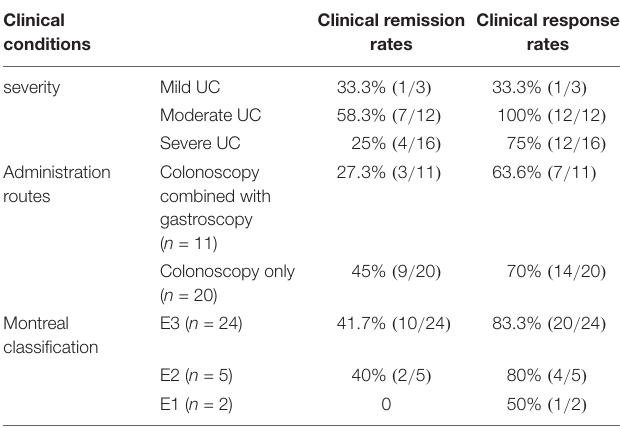
TABLE 2 | Clinical efficacy after two FMT treatments under different